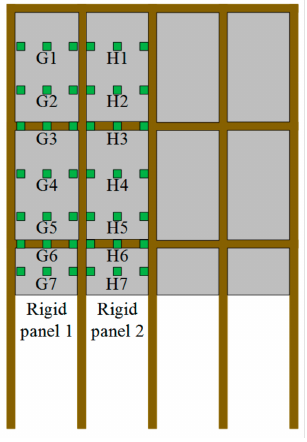
Figure 16. The layout of the strain gauges installed on the rigid panels.